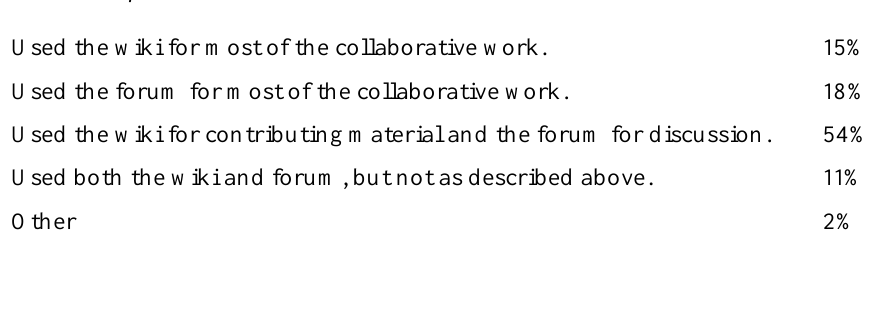
How Groups Use the Wiki and the Forum for the Collaborative Work Used the wiki for most of the collaborative work. 15% Used the forum for most of the collaborative work. 18% Used the wiki for contributing material and the forum for discussion. Used both the wiki and forum, but not as described above.